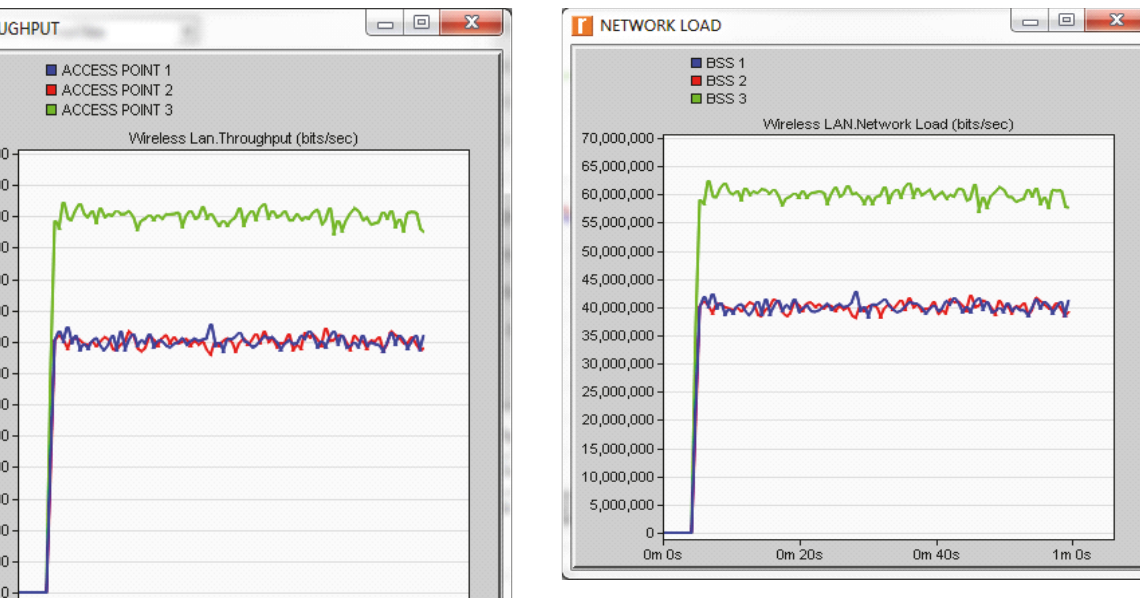
Figure 4: Network load of different BSSs.